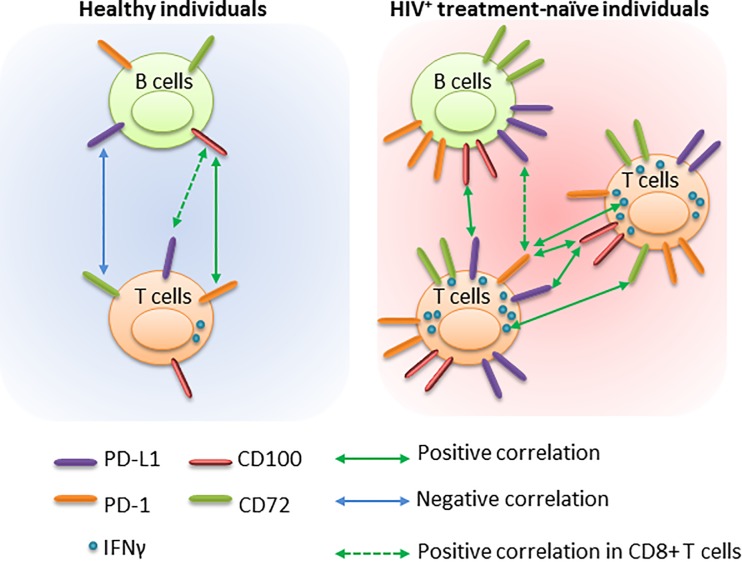
Summary of the potential relationships between B and T cells in healthy and in HIV+ treatment-naïve individuals.